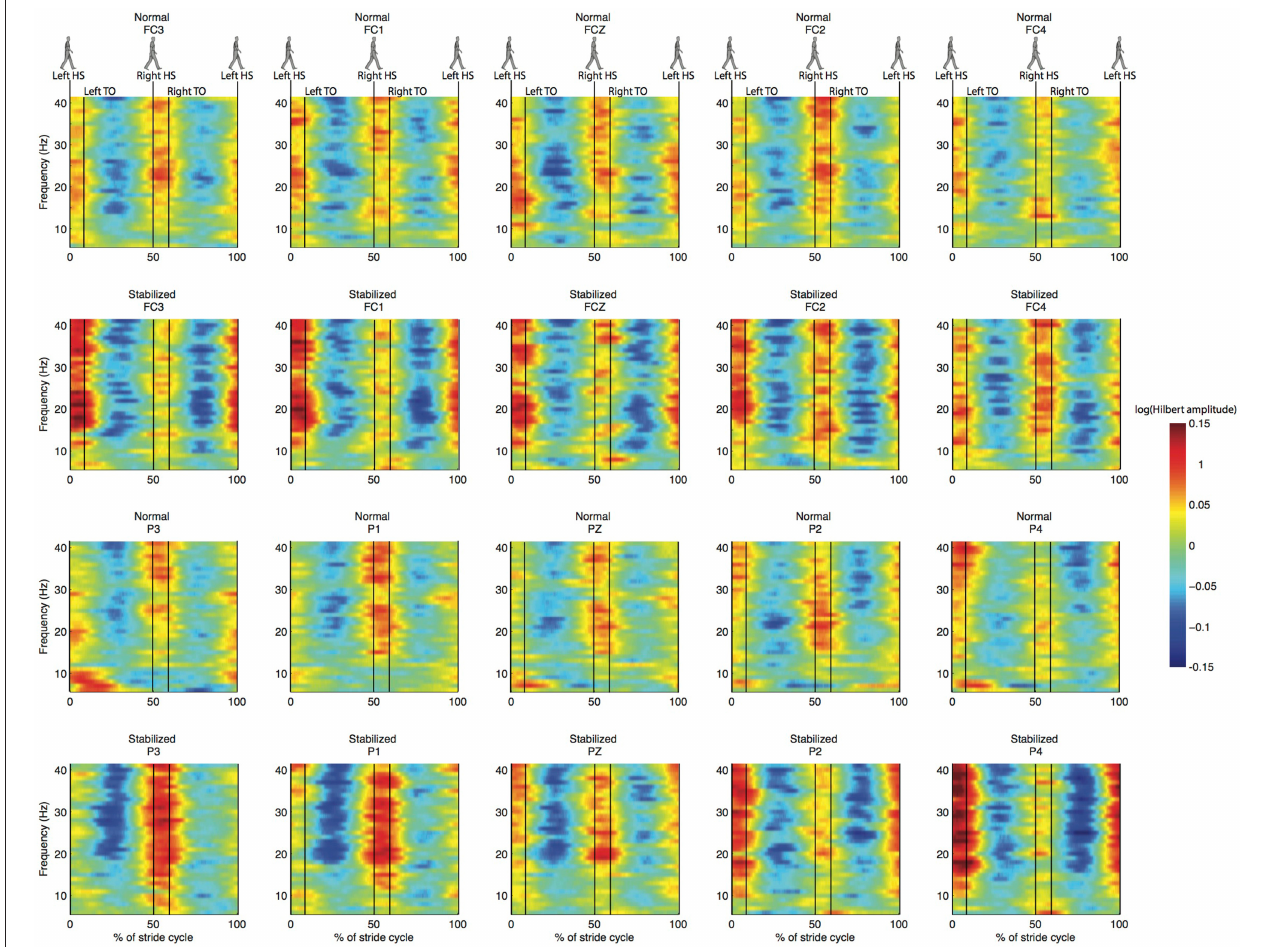
FIGURE 5 | Normalized ERSP for the same electrodes as in Figure 4. First and third row are for normal walking, second and fourth for stabilized walking.